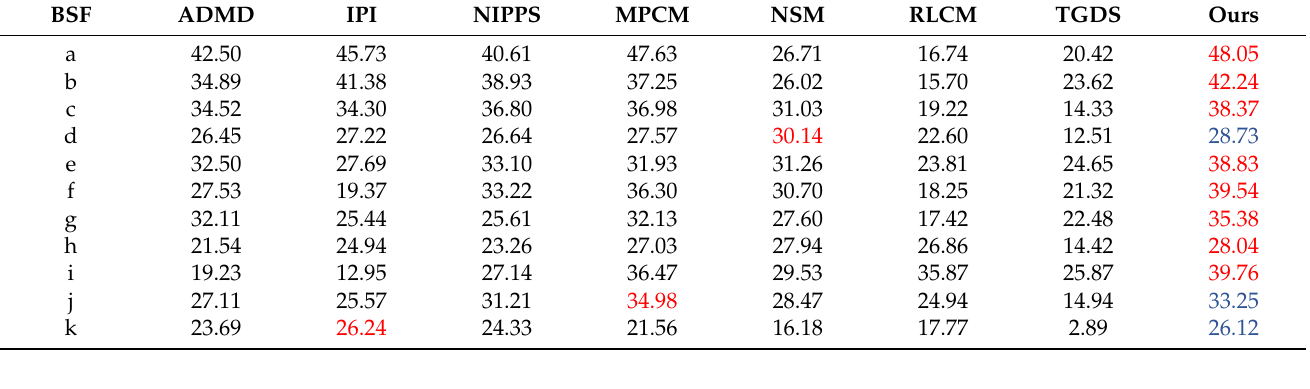
Table 3. BSF values of different methods.